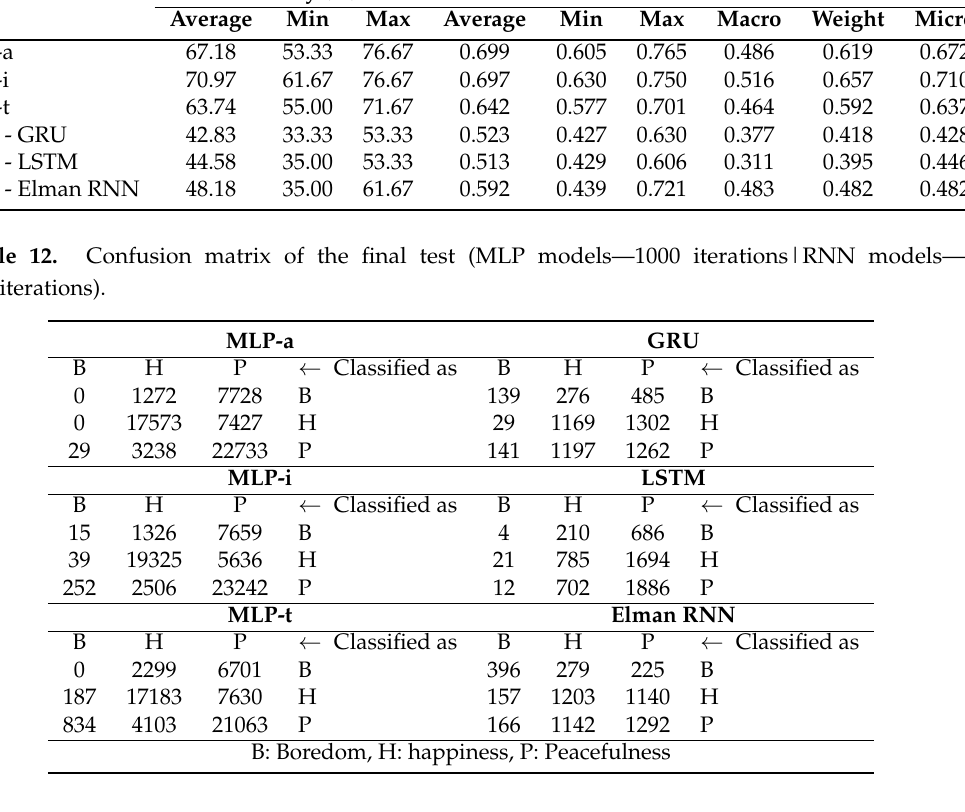
and five-fold cross validation were not significantly different, and the results using LOOCV were slightly higher than the average scores in 1000 iterations of five-fold cross validation results. This could be because the training sample size increases in LOOCV compared to 5-fold cross